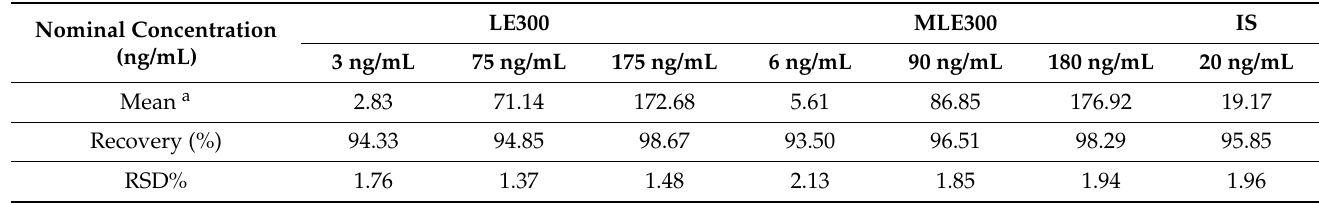
Table 5. Recovery of LE300 and MLE300 QC samples in rat plasma.